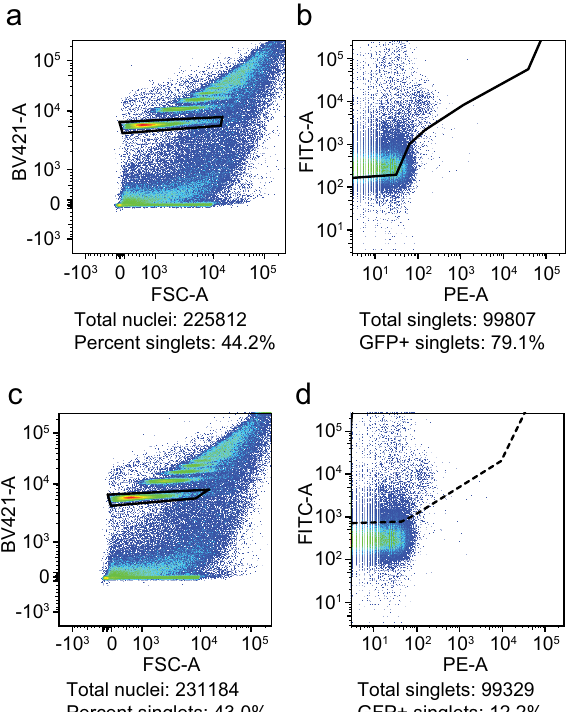
Figure 2. Differential sensitivity at the low and high sorting gate. S uper-bright nuclear GFP expression was driven using tubulin - Gal4 (all nuclei are GFP+). Nuclei from heads were isolated and analyzed by flow cytometry using low- and high-stringency gating. ( a ) 79% of nuclei were GFP+ at the low gate (solid trapezoid). ( b ) 12% of nuclei were GFP+ at the high gate (stippled trapezoid). The left panels show forward scatter vs. DAPI staining and the right panels show GFP